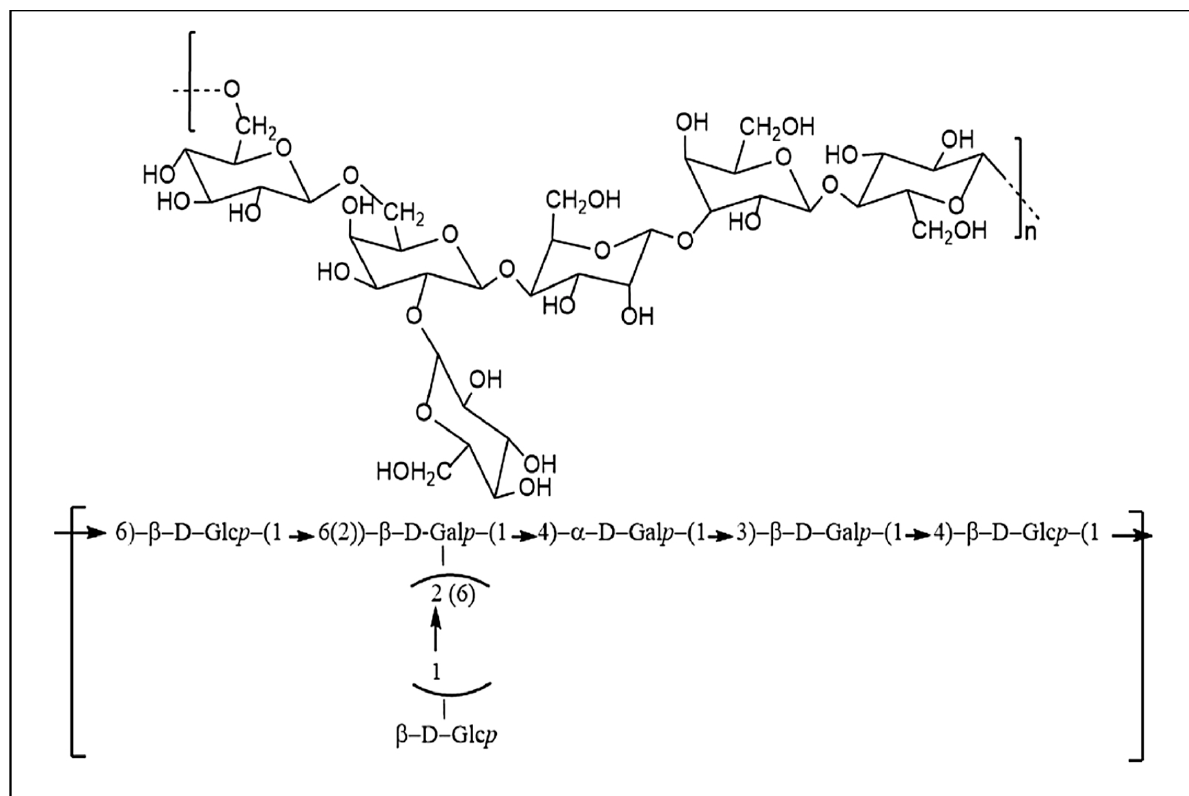
Figure 3. Proposed molecular structure of the heteropolysaccharide kefiran—chair configuration [101].